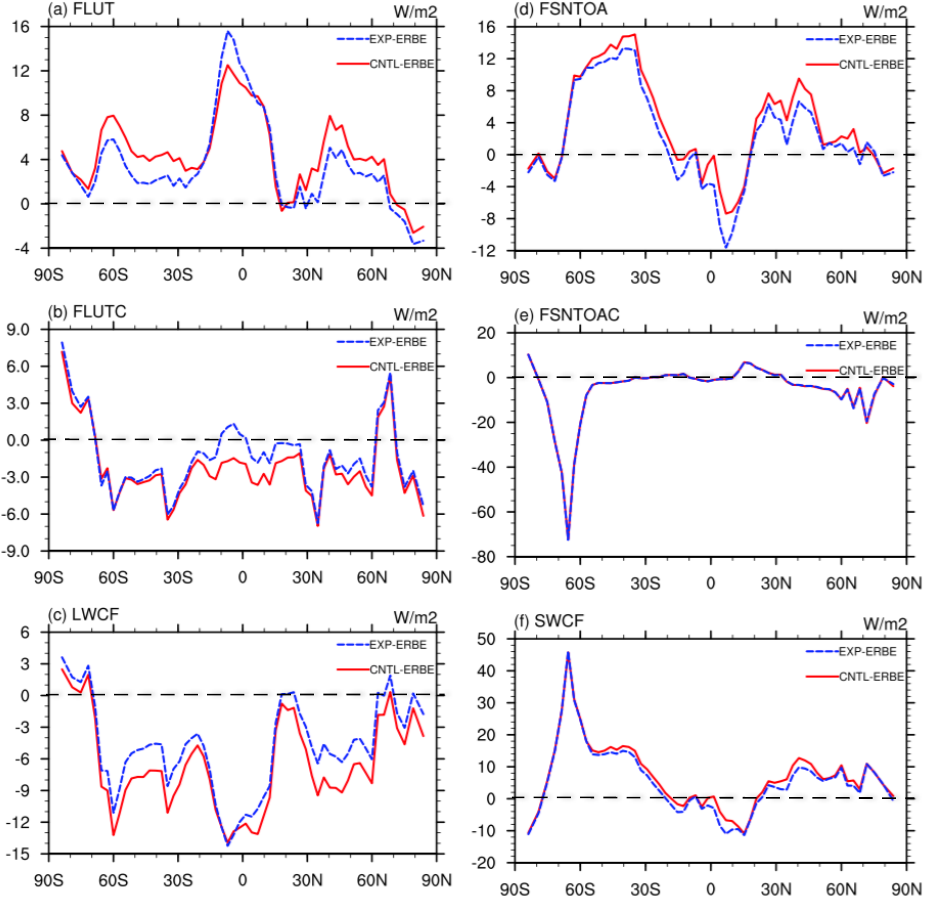
Figure 7. Meridional distributions of the annual mean difference between EXP/CNTL and observations of TOA outgoing long-wave radia- tion (a) , TOA clear-sky outgoing long-wave radiation (b) , TOA long-wave cloud forcing (c) , TOA net short-wave flux (d) , TOA clear-sky net short-wave flux (e) , and TOA short-wave cloud forcing (f)